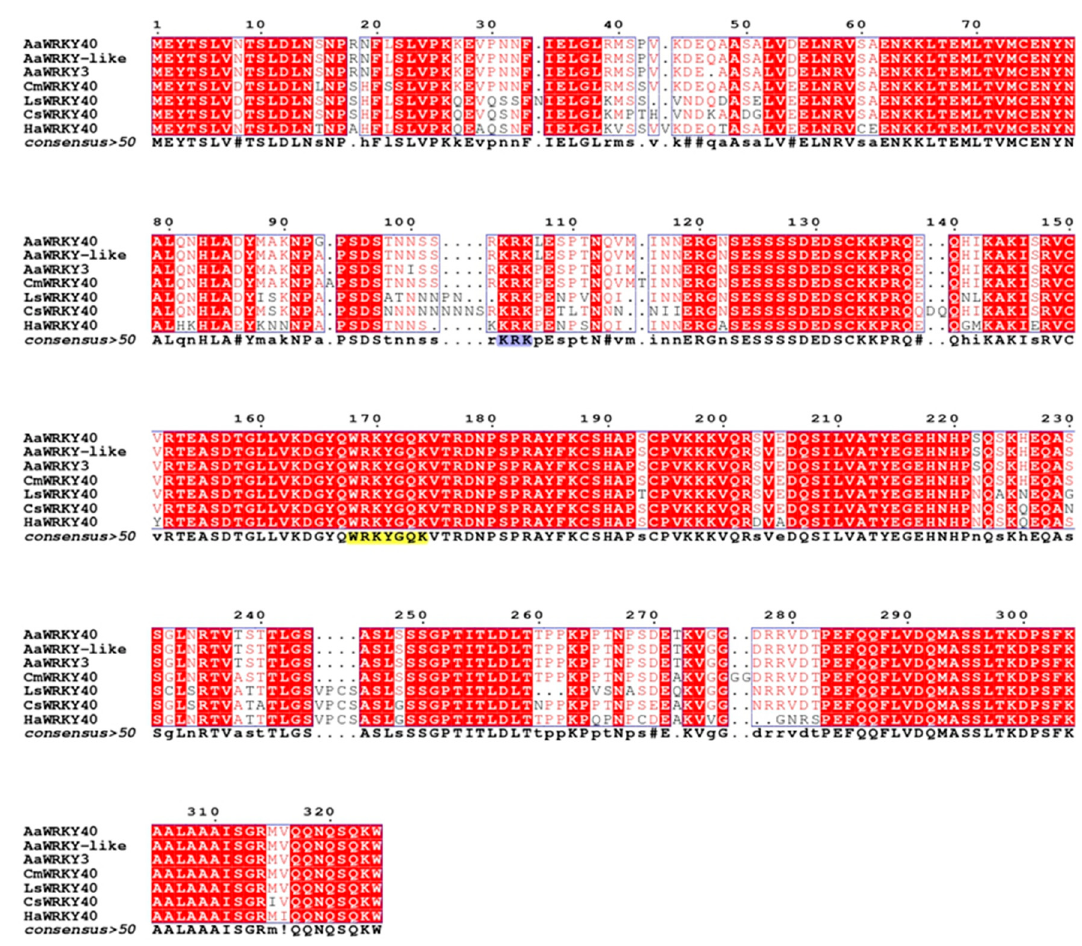
Figure 2. Alignment of AaWRK40 with related WRKY proteins from other Asteraceae plant species. The deduced amino acid sequence of AaWRK40 was aligned with Aa WRKY-like PWA73483.1, AaWRKY3 AGR40499.1, Cxm WRKY40 AJF11723.1, Ls WRKY40 XP_023744098.1, Ha WRKY40 XP_022015554.1(83%), CsWRKY40 XP_024969930.1, using MultAlign software [29] with default parameters. Predicted domains are indicated above the sequences.